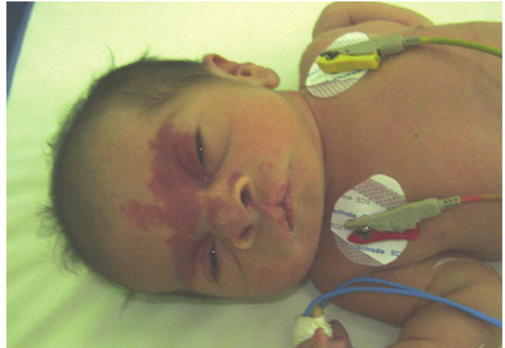
Figure 1: Phenotypical findings described on the text. (With parent’s permission).